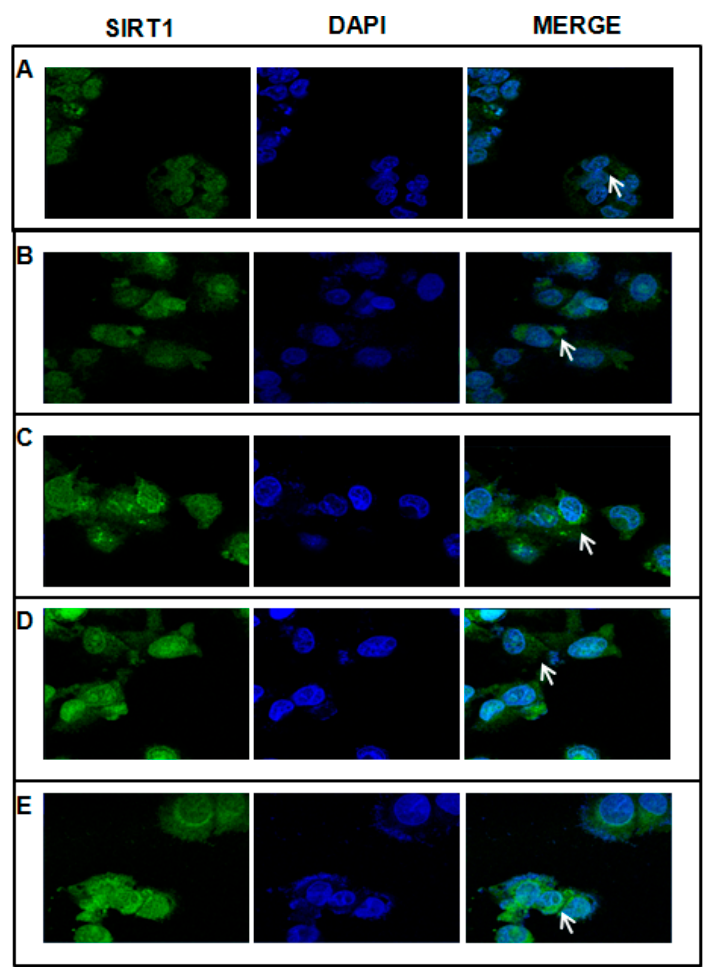
Figure 2. Effect of AdoMet and Tyr on subcellular localization of SIRT1. HepG2 without treatment ( A ); Et-HepG2 (cells treated for 4 h with 1 M ethanol and then incubated for 48 h without ethanol) ( B ); Et-HepG2 treated for 48 h with 100 µM AdoMet ( C ); Et-HepG2 treated for 48 h with 10 µM Tyr ( D ); Et-HepG2 treated for 48 h with 100 µM AdoMet/10 µM Tyr ( E ). Cells were incubated with anti-SIRT1 (green). The nuclei were stained with DAPI (blue). The white arrows indicate the SIRT1localization. Images were obtained by an LSM-410 Zeiss confocal microscope.